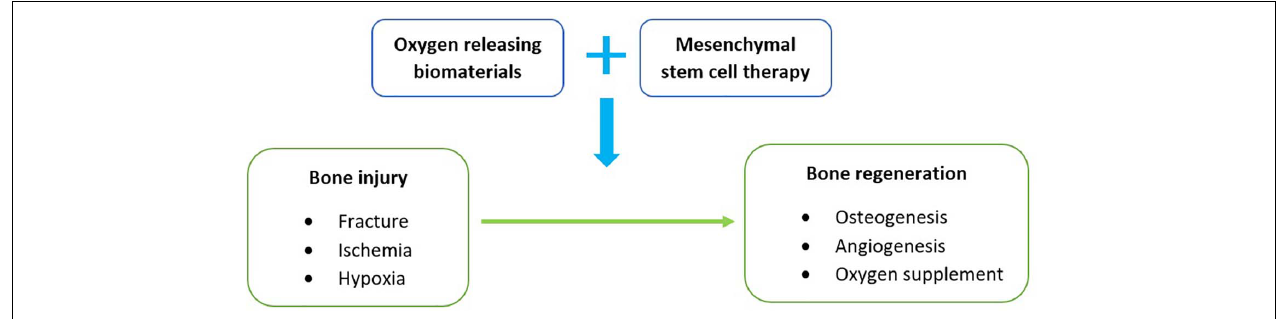
FIGURE 1 | A schematic diagram of the review